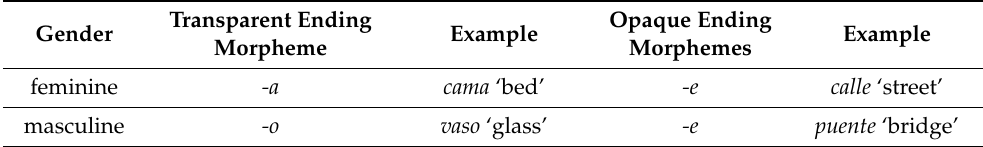
Table 1. Spanish transparency/opacity noun gender system.